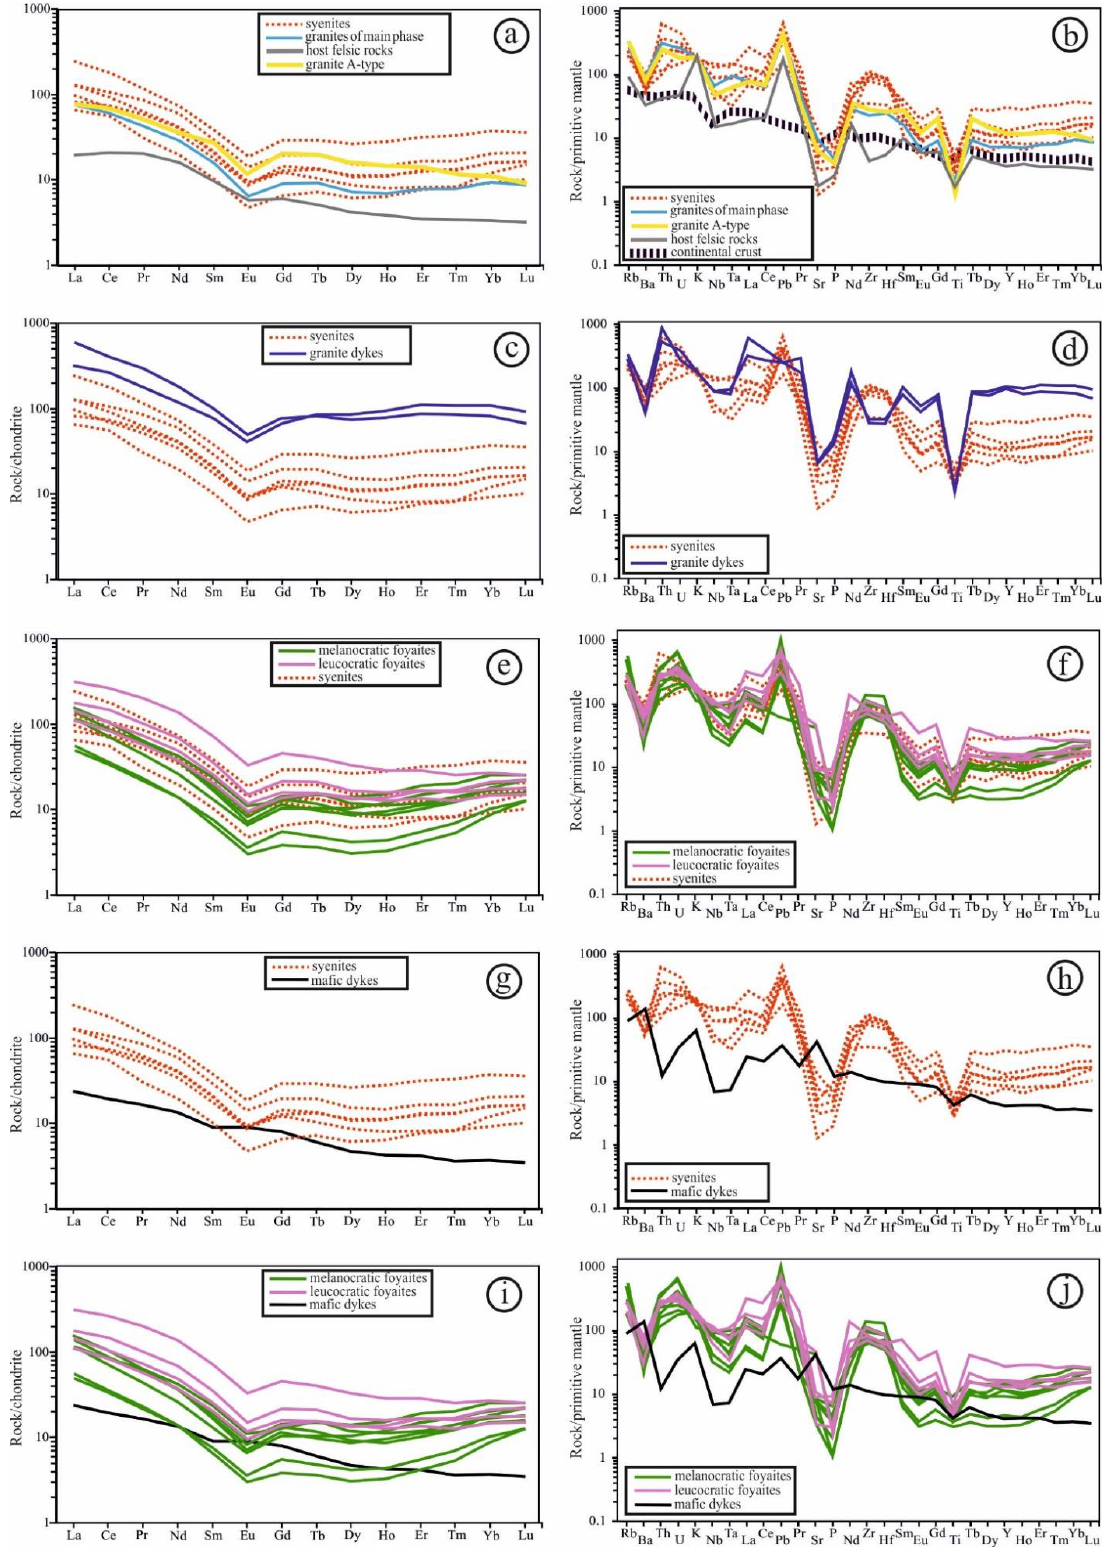
Figure 9. ( a – j ) REE diagram, normalized to chondrite [72], and spidergram, normalized to primitive mantle [72], for the Saibar rocks. The figure illustrates that leucocratic foyaites are enriched in LREEs and MREEs in comparison with the melanocratic foyaites. Dyke granites are enriched in Th, U, and REEs in comparison with granites of the main phase. Syenites are similar in geochemical characteristics to foyaites. A-type (anorogenic) granites are from [73]. Continental crust is from [74].